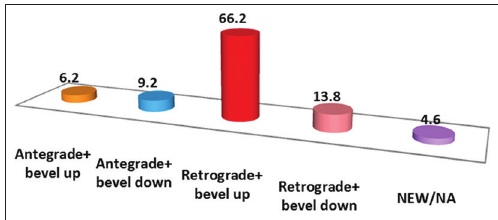
FIGURE 3. Bevel position during needling vascular access.